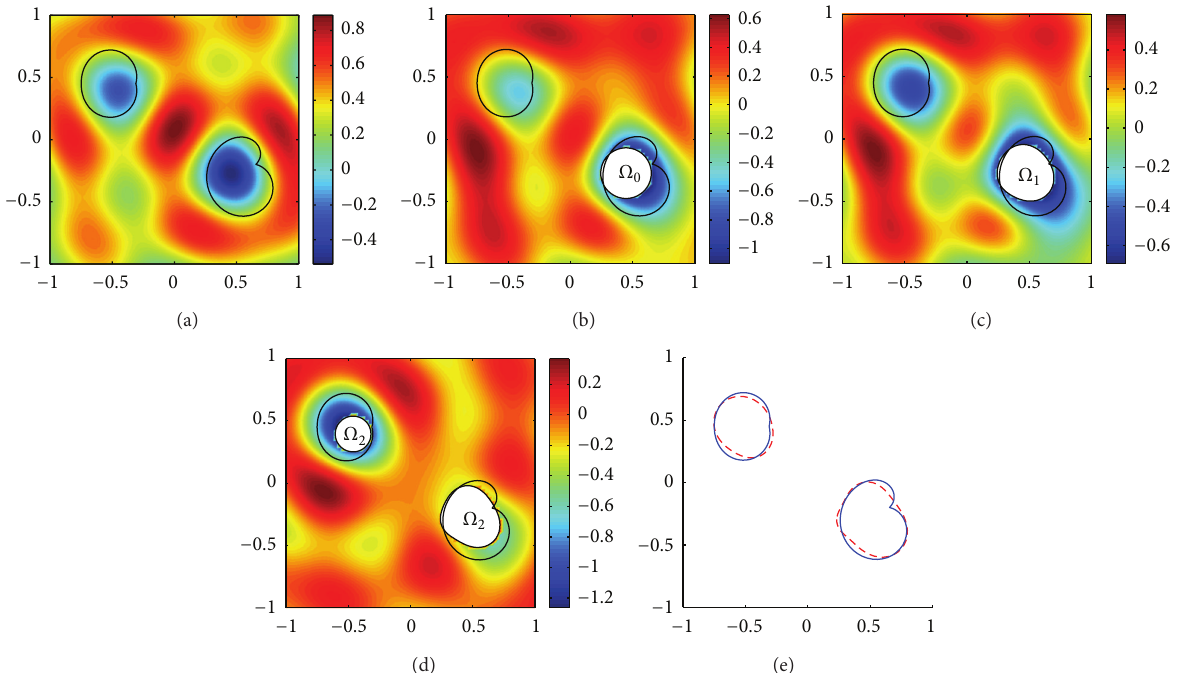
Figure 10: Reconstruction of sound-soft objects. (a) Topological derivative when Ω = 0 . (b) Initial guess Ω 0 superimposed to the topological derivative for Ω = Ω 0 . (c)-(d) Approximate domains Ω 𝑚 superimposed to the topological derivative for Ω = Ω 𝑚 , for 𝑚 = 1 and 𝑚 = 2 . (e) Final reconstruction of the objects after 13 steps (dashed red